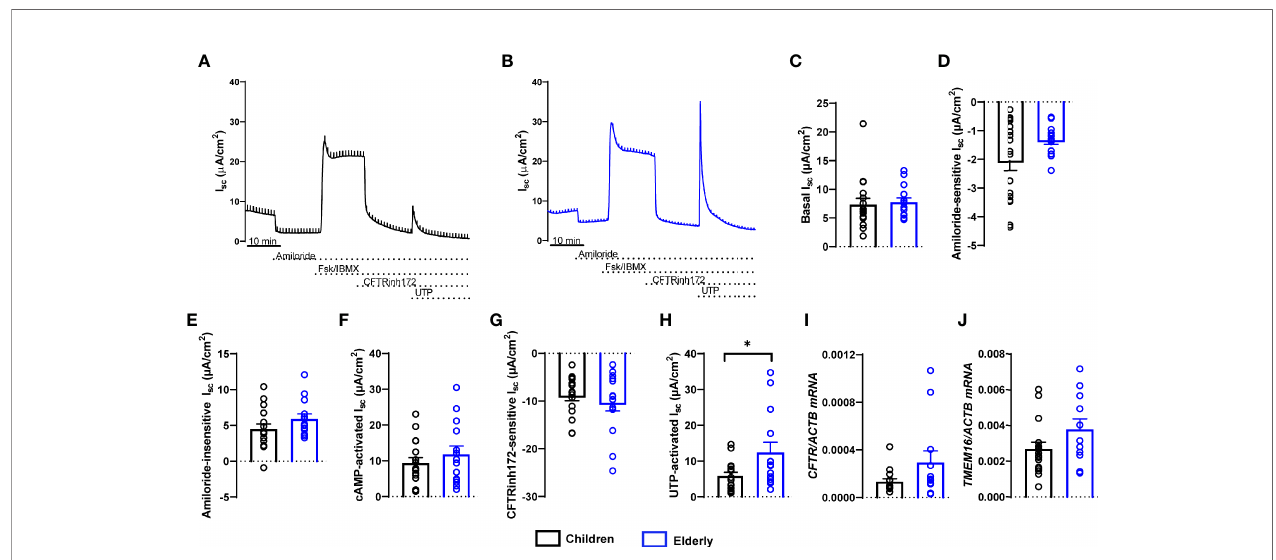
FIGURE 2 | Age-related differences in calcium-activated chloride secretion in nasal epithelial cultures from healthy children compared to elderly people. (A, B) Representative original recordings of transepithelial Ussing chamber measurements in primary nasal epithelial cultures from children and elderly people. (C – G) Summary of individual effects of basal I sc (C), amiloride-sensitive I sc (D) , amiloride-insensitive I sc (E) , cAMP-activated I sc (F) , CFTR inhibitor 172-sensitive I sc (G) , and UTP-activated I sc (H) ( n = 17 and 14 individuals per group, data represent mean values of 2 – 3 fi lters per individual). (I, J) Transcript levels of CFTR (I) and TMEM16A (J) ( n = 16 and 12 individuals per group). * p < 0.05 compared to children. Data are shown as mean±S.E.M. Statistical analysis was performed with unpaired two-tailed t -test in (D – G) , and with two-tailed Mann – Whitney test in (C, H – J)